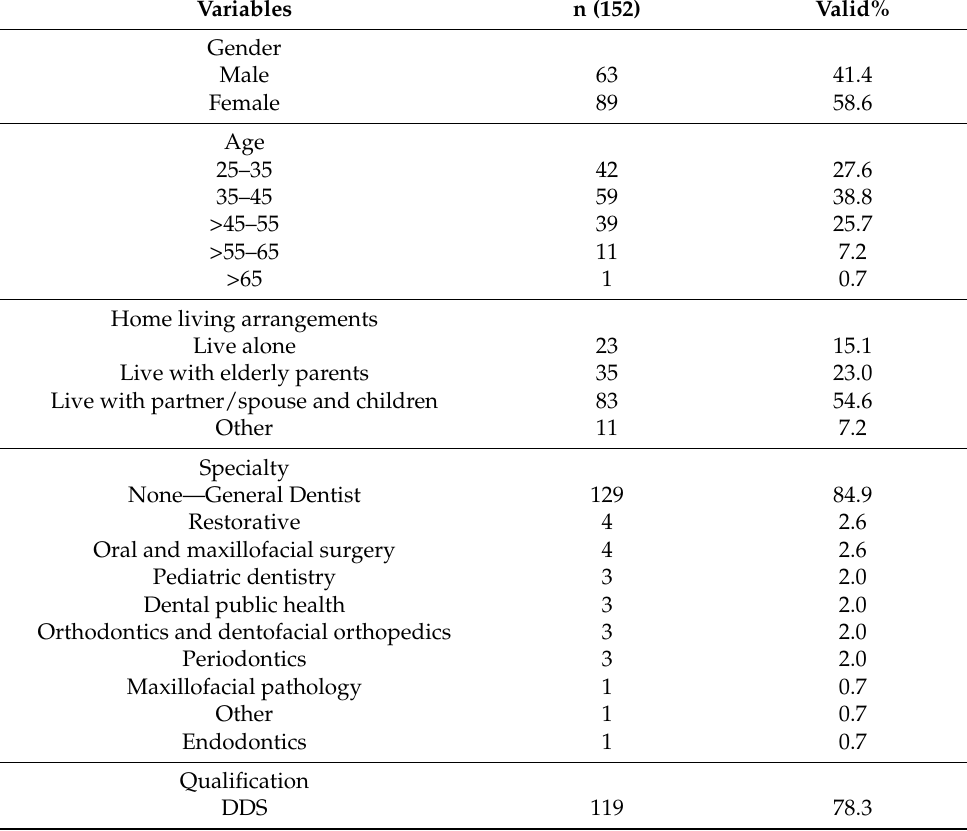
Table 1. Demographics of